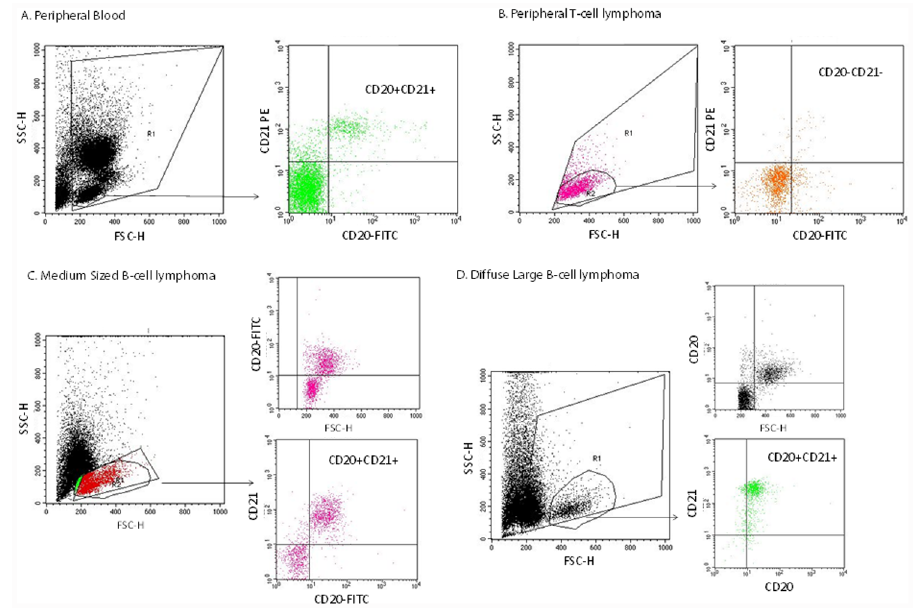
Fig 4. Expression of CD20 protein in clinically-derived canine cell populations. The highlighted cell sample populations were isolated and processed as indicated in the materials and methods. Expression of CD20 (and CD21) in the population of cells were analyzed by FACS and include (A) peripheral blood; (B) peripheral T-cell lymphoma; (C) Medium sized B-cell lymphoma; and (D) Diffuse Large B-cell